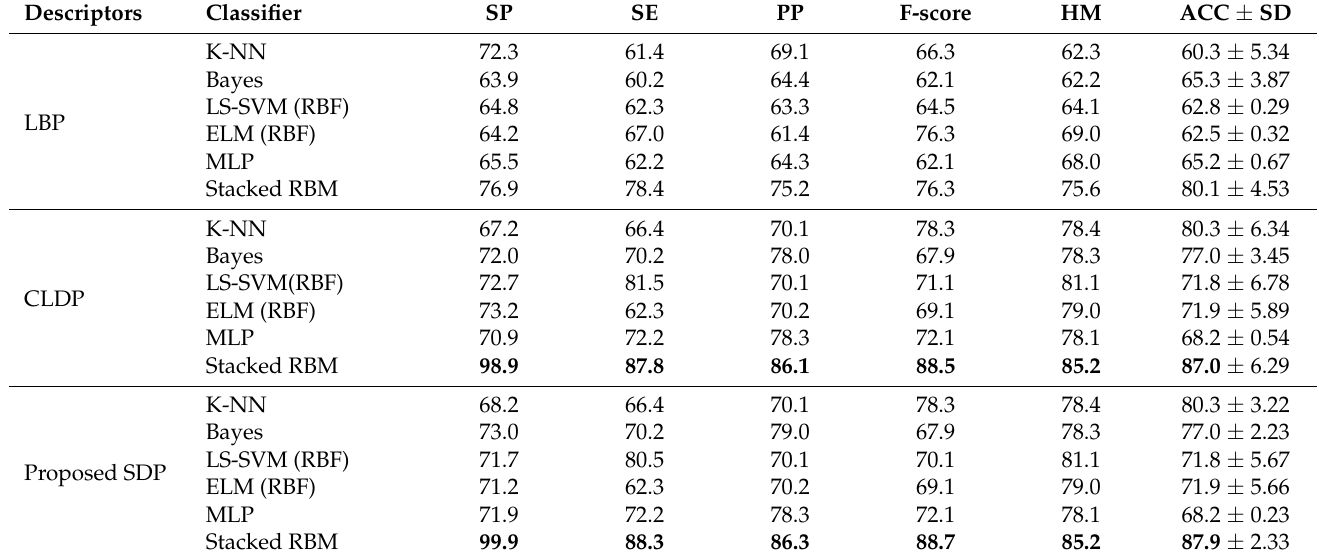
Table 11. Classification outcomes of Dermnet.